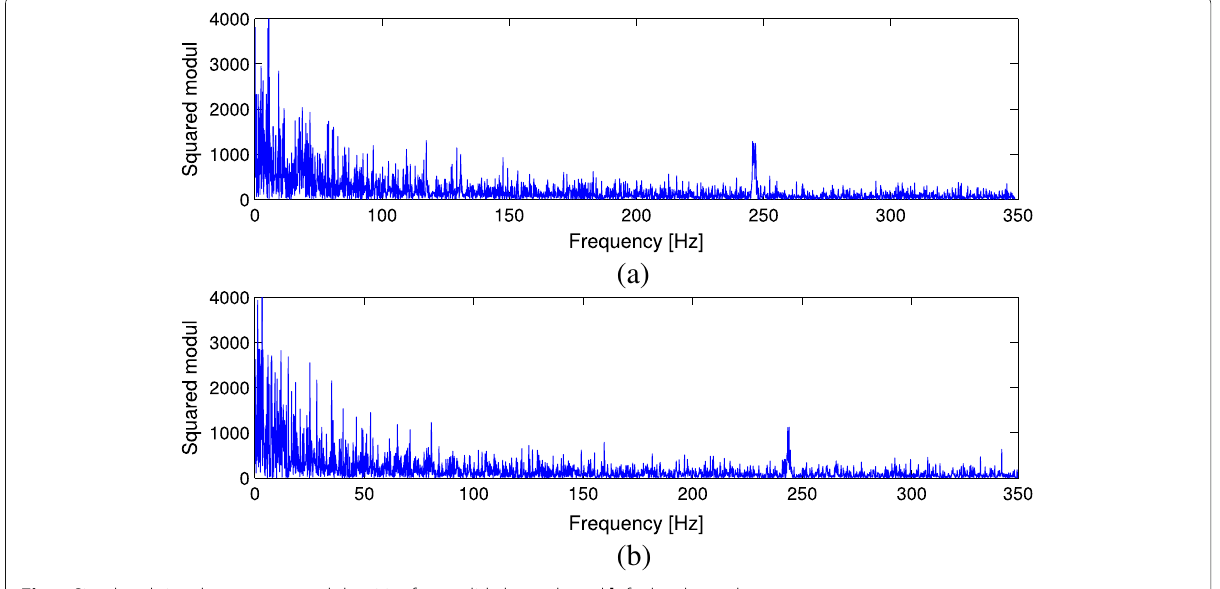
Fig. 7 Simulated signal energy spectral densities for a valid electrode and b faulty